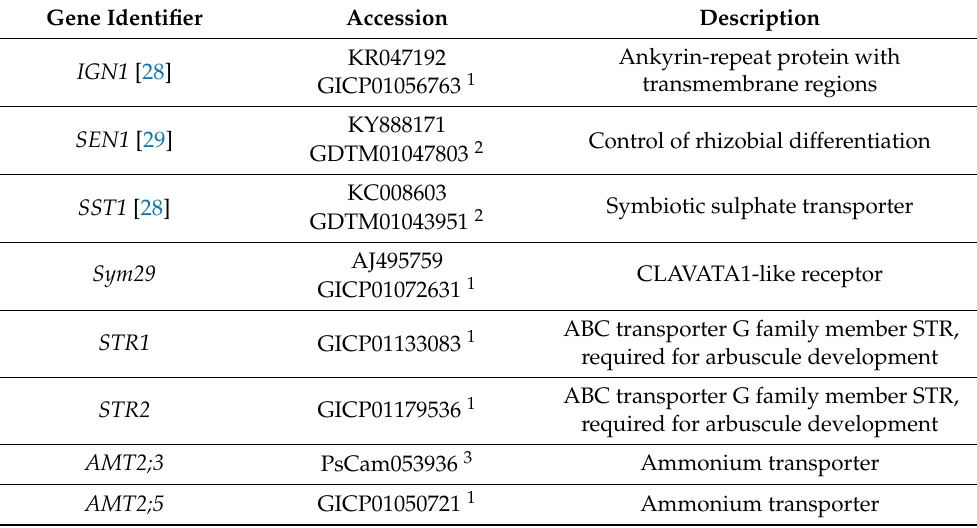
Table 1. The Sym genes selected for association